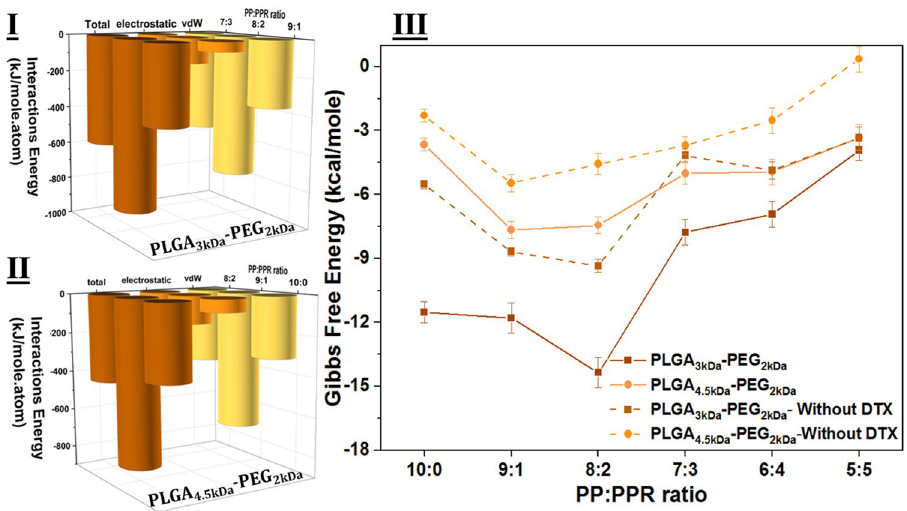
Figure 4. Energy assessment of simulations. ( I ) and ( II ) Formation enthalpy of particles based on PLGA¬3 kDa-PEG2 kDa and PLGA¬4.5 kDa-PEG2 kDa, respectively. It is obvious that for both sets of NPs, the vdW interaction is the dominant interaction in the assembly of polymers and drugs. ( III ) absolute criteria of stability based on Gibbs free energy. Drug loading into NPs lowers the Gibbs energy level, which means that particles are more